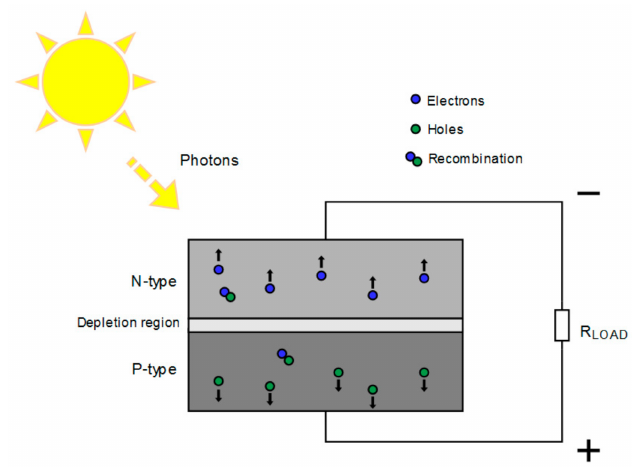
Figure 3. Simplified operation of a solar